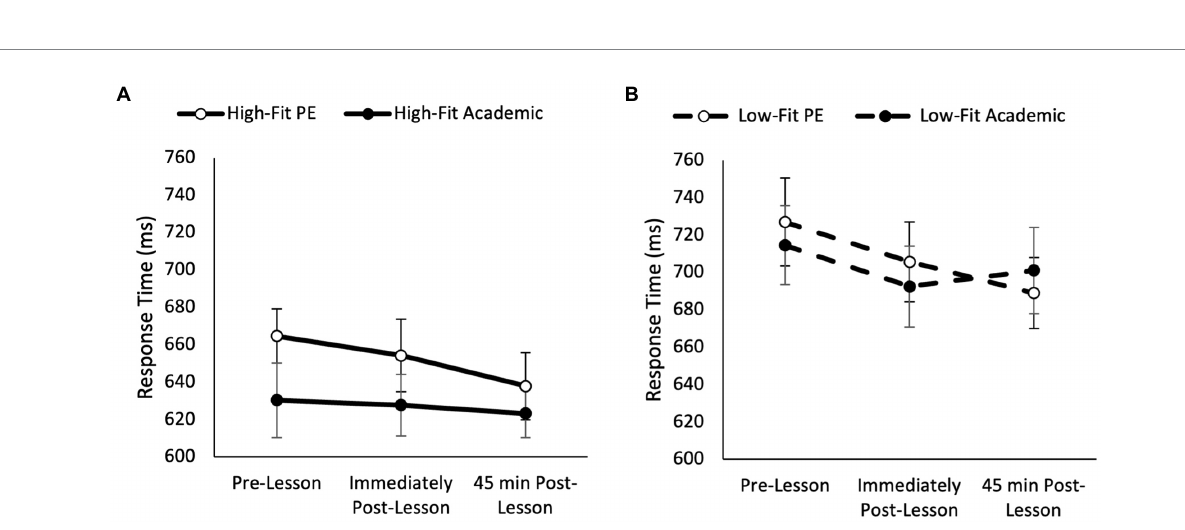
(main effect of MVPA, p = 0.774). The pattern of change was similar between trials (trial * time, p = 0.659) and was not affected by fitness (time * trial * fitness, p = 0.453) or MVPA during the PE lesson (trial * time * fitness, p = 0.312).